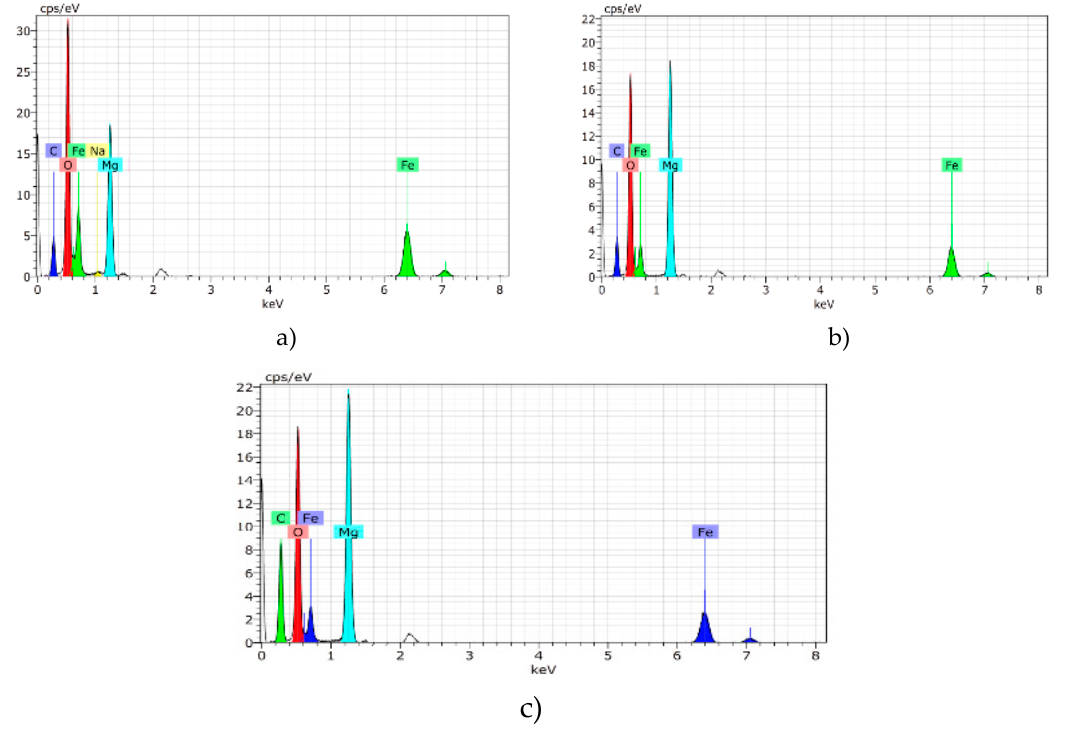
Figure 6. Energy-dispersive X-ray spectroscopy of activated layered double hydroxides at 5000x. a ) LDHM1F-400 °C, b ) LDHM2F-400 °C, c ) LDHM3F-400 °C.